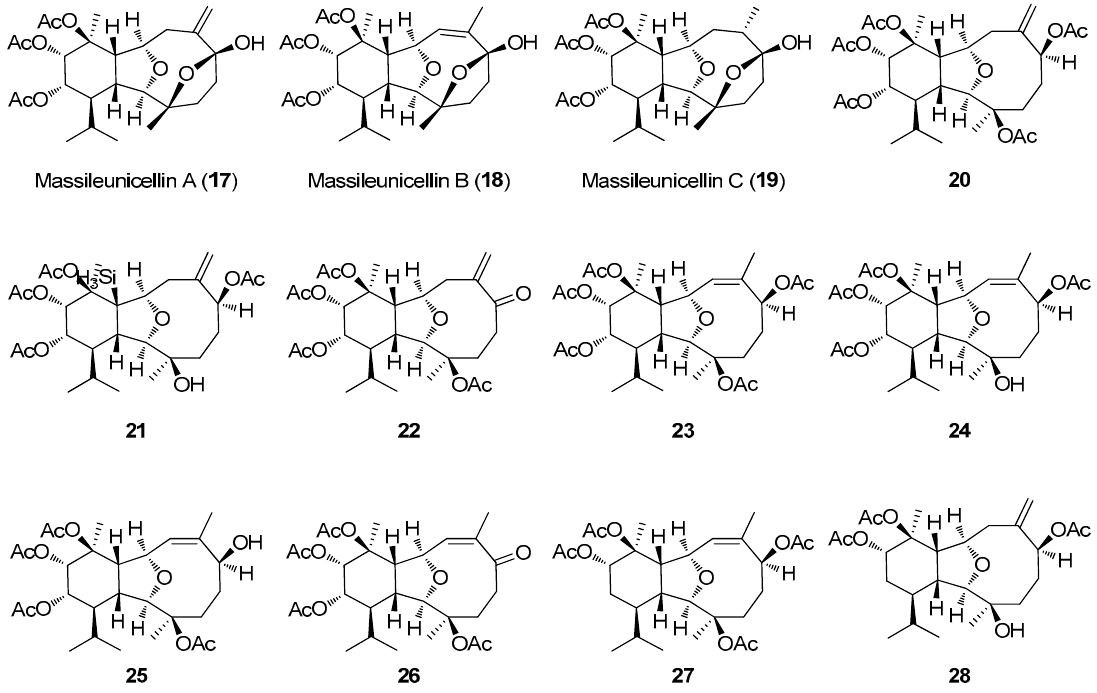
Figure 8. Massileunicellins A–C ( 17 – 19 ) and diterpenoids ( 20 – 26 ) isolated from E. cavolini , as well as ( 27 , 28 ) isolated from E. singularis .